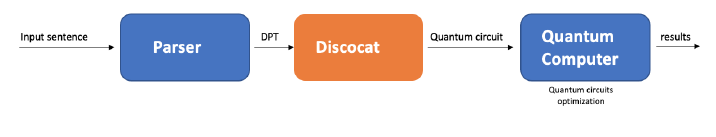
Figure 3. A simplified version of the pipeline proposed by